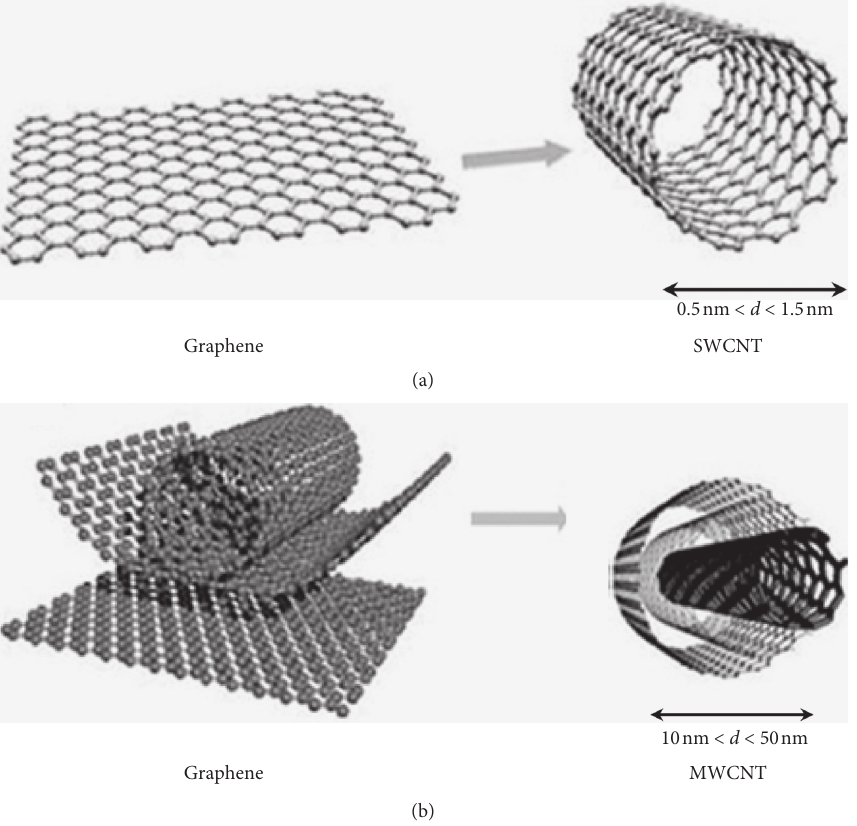
Figure 4: Representation of a typical (A) single-walled carbon nanotube (SWCNT) and a multiwalled carbon nanotube (MWCNT) (adapted from reference